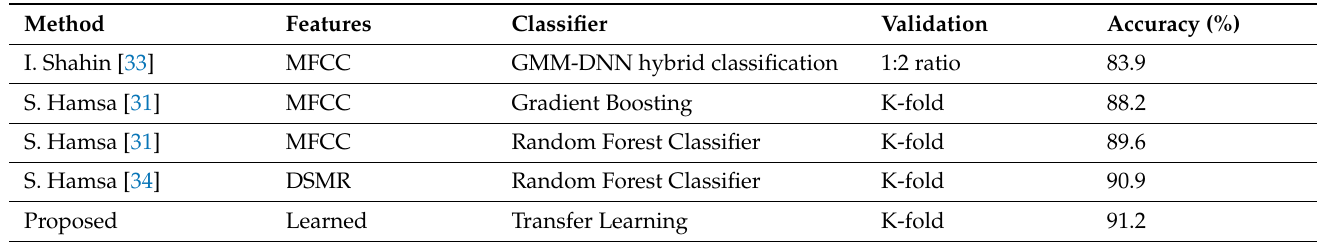
Table 2. Performance analysis of various advanced methods using the ESD dataset.